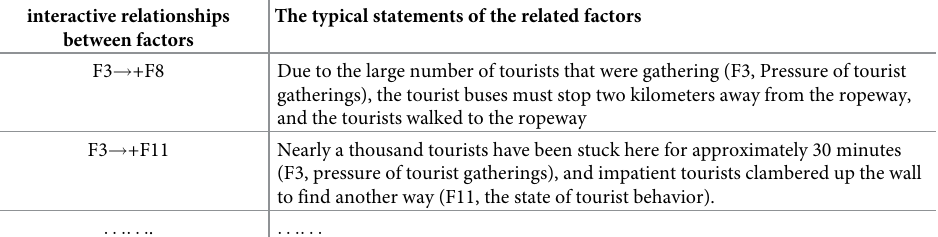
Table 2. The typical statements of the related factors and their interactive relationships of operational mechanism of HATCs in a safe state. interactive relationships between